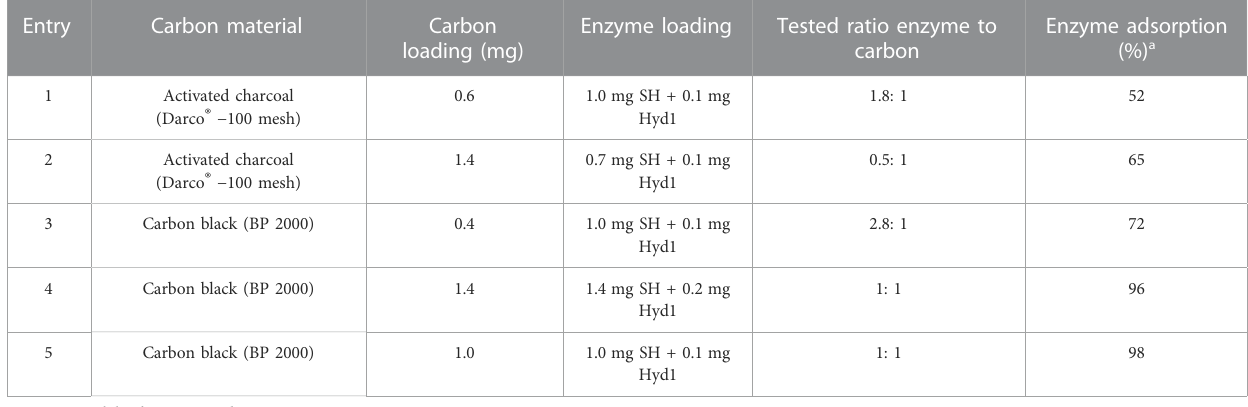
Table 5, entry 2 was also adjusted to pH 12 using 3 M aqueous NaOH, extracted into chloroform, then analysed using chiral- phase GC-FID (see S2.3 in the Supplementary Information for details).